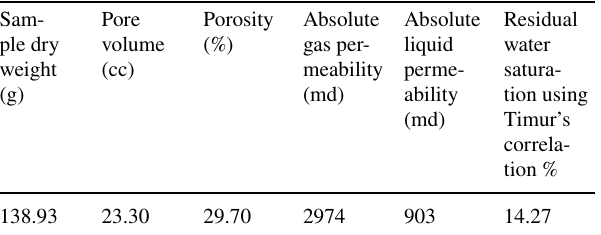
Table 5 Idaho gray sandstone core plug properties Sam- ple dry